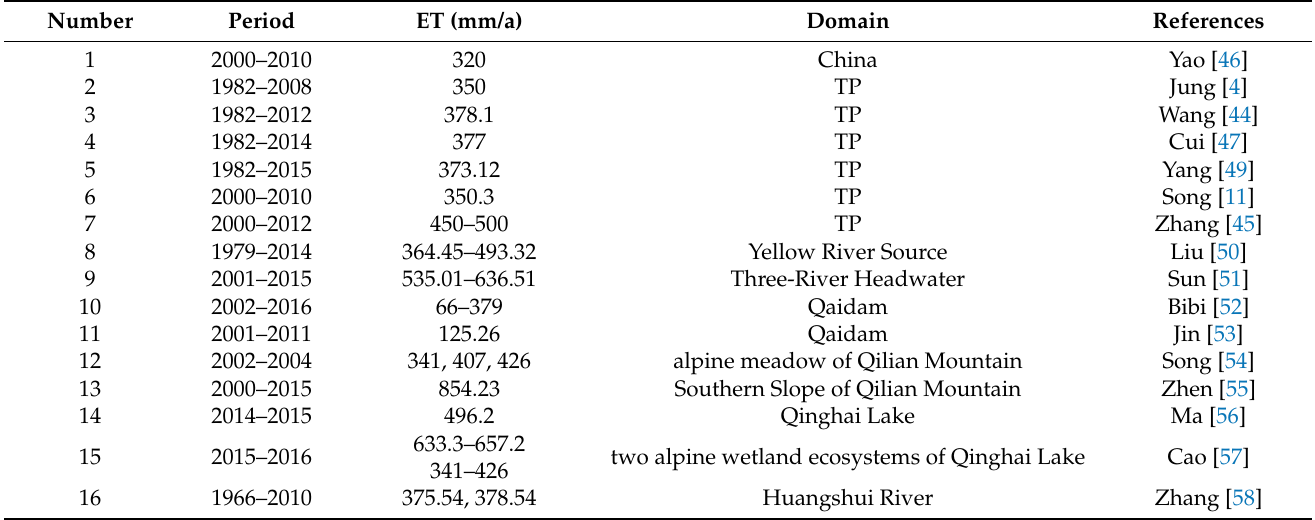
Table 2. Comparison of ET in Qinghai Province with the